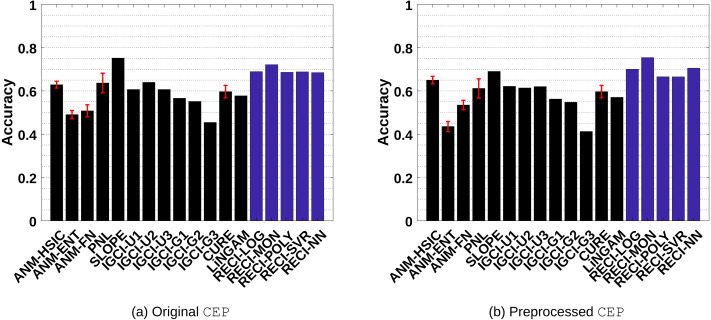
Evaluation results of all methods in the real-world CEP data sets.(A) shows the result of the evaluations in the original data and (B) the results in the preprocessed versions where low-density points were removed.